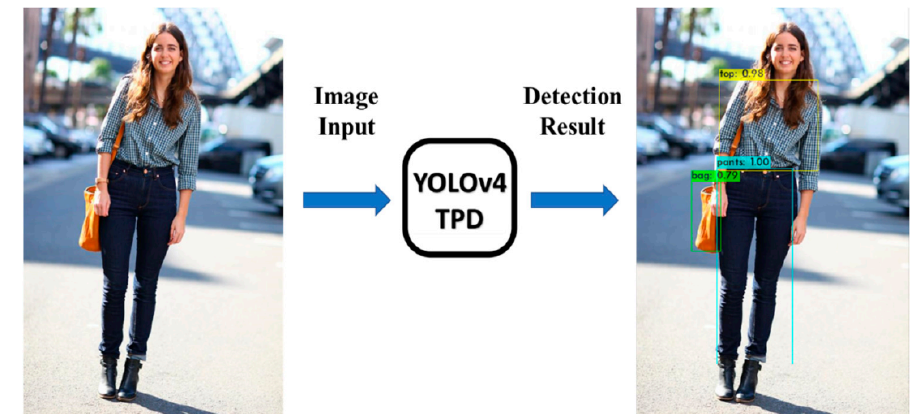
Figure 1. Fashion apparel detection with YOLOv4-TPD.